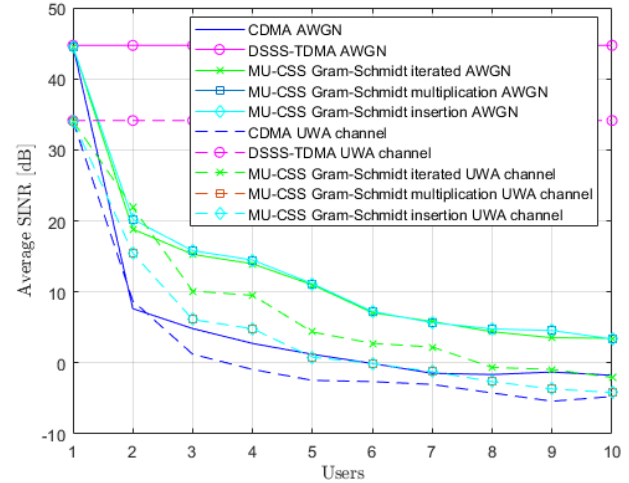
Figure 5. Average Signal-to-Interference-plus-Noise Ratio (SINR) for different waveforms over the Additive White Gaussian Noise (AWGN) and time-varying UWA channels with static users, SNR = 30